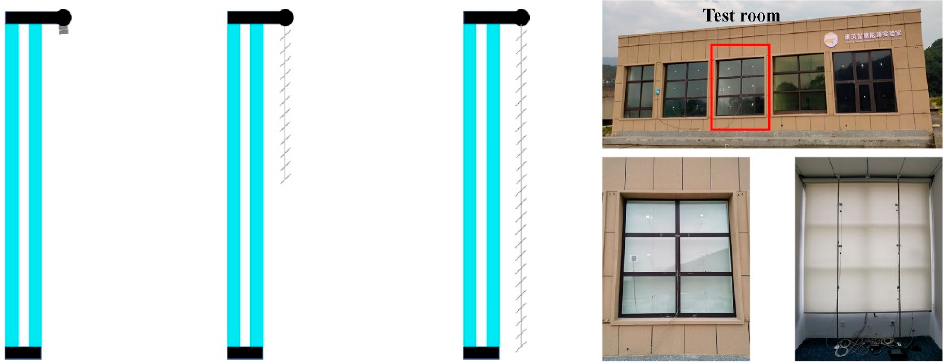
Figure 25. The outside view of the test room, along with the position of the shading devices [87].